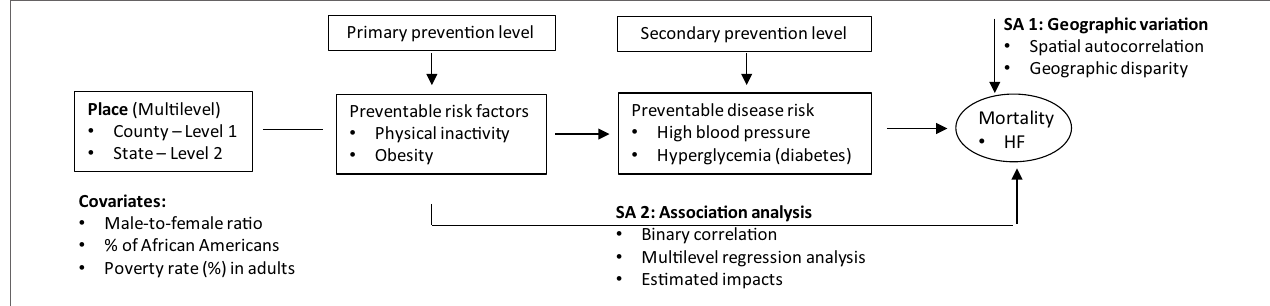
FigUre 1 | Conceptual model and analysis framework for specific aims (SA) 1 and 2.